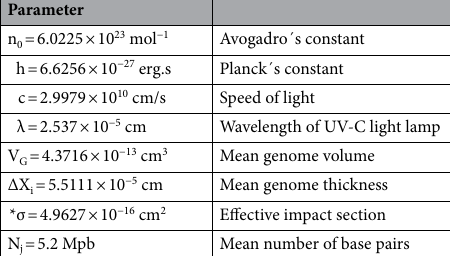
Table 3. Physical parameters of the models (constants). * See the Appendix 1 derivation of EIS 22 .